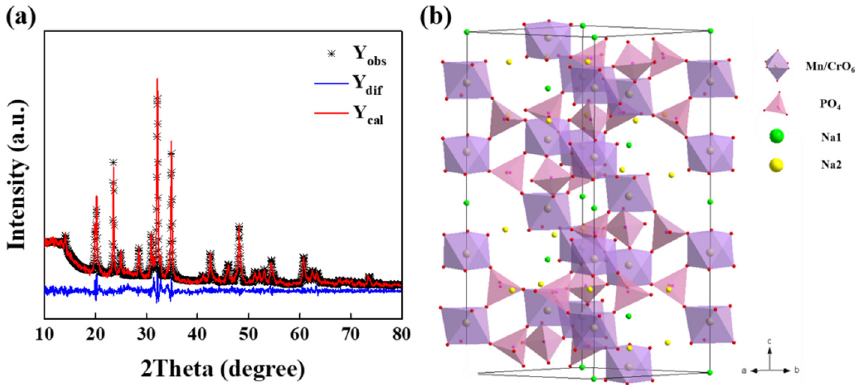
Figure 2. ( a ) X-ray diffraction (XRD) and corresponding Rietveld refinement results of NMCP/rGO; ( b ) crystal structural of NMCP and the coordination of cations.